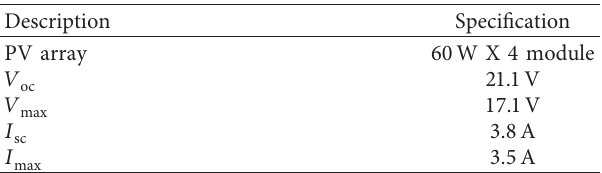
Table 4: The PV module